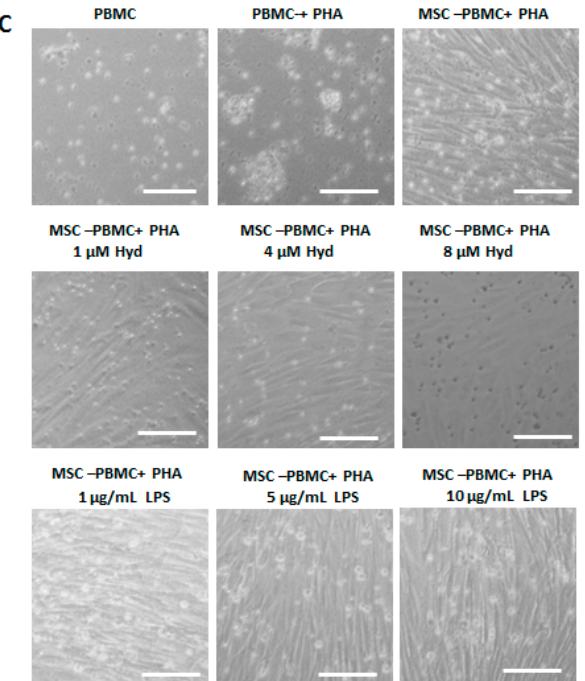
Figure 3. Stimulation with Hydrocortisone or E. coli O111:B4 affects BMSC immunosuppressive function. ( A ) Percentage of T-cells was determined by flow cytometry after coculture with BMSCs in the presence of Hydrocortisone or LPS from E. coli O111-B4. The results of statistical analysis for the percentage of CD3 + CD45 + T cells are depicted as the mean ± S.D for the three cell lines (BMSC22, BMSC32 and BMSC34) evaluated. ( B ) Representative example of gating strategy for determination of T cell population after coculture with BMSC22 in presence of Hydrocortisone or LPS from E. coli O111-B4. ( C ) Representative images of BMSC22 and PBMC coculture in presence of Hydrocortisone or LPS from E. coli O111-B4. Scale bar: 50 µm. * p < 0.05 versus MSC-PBMC only (3rd column), as determined